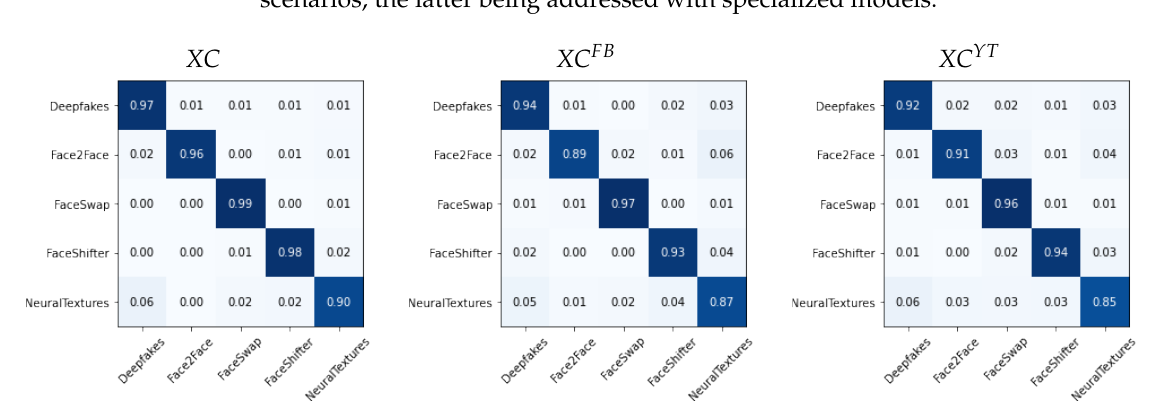
Figure 6. Confusion matrices obtained from XC ( x ) in the pre-social and post-social scenarios.